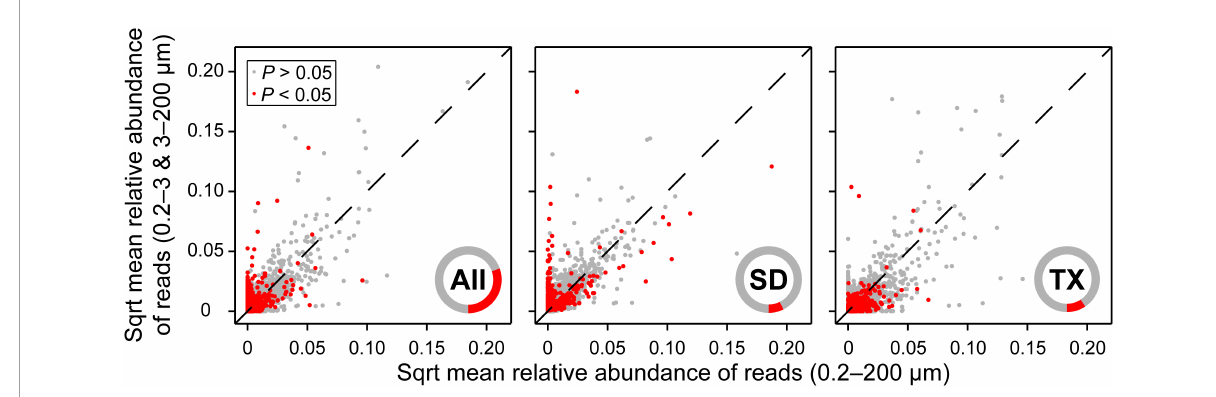
FIGURE2 Comparison of relative abundance of OTUs between 0.2–200 µ m and 0.2–3 and 3–200 µ m eukaryotic plankton fractions. More than two-thirds of OTUs (69.58%) showed no significant difference in the relative abundance of reads between the two size-fractionated plankton communities in both reservoirs. The mean relative abundance of reads was square root transformation (Sqrt). Statistical analysis is the non-parametric Mann–Whitney U test. Data are presented as the mean of 40 replicates for 16472 OTUs in both reservoirs, 20 replicates for 14739 OTUs in the Shidou Reservoir and 20 replicates for 14540 OTUs in the Tingxi Reservoir, respectively. The operational taxonomic units (OTUs) were defined at 97% sequence similarity threshold. Only 5010 (30.42%), 1072 (7.27%), and 1358 (9.34%) OTUs were significant differences between the two size-fractionated plankton communities in both reservoirs (All), Shidou Reservoir (SD) and Tingxi Reservoir (TX), respectively. The inner red/gray cycles show the composition proportion with/without statistical differences, which more intuitively reflects the proportion with significant differences between the 0.2–200 µ m and 0.2–3 and 3–200 µ m size-fractionated eukaryotic plankton.